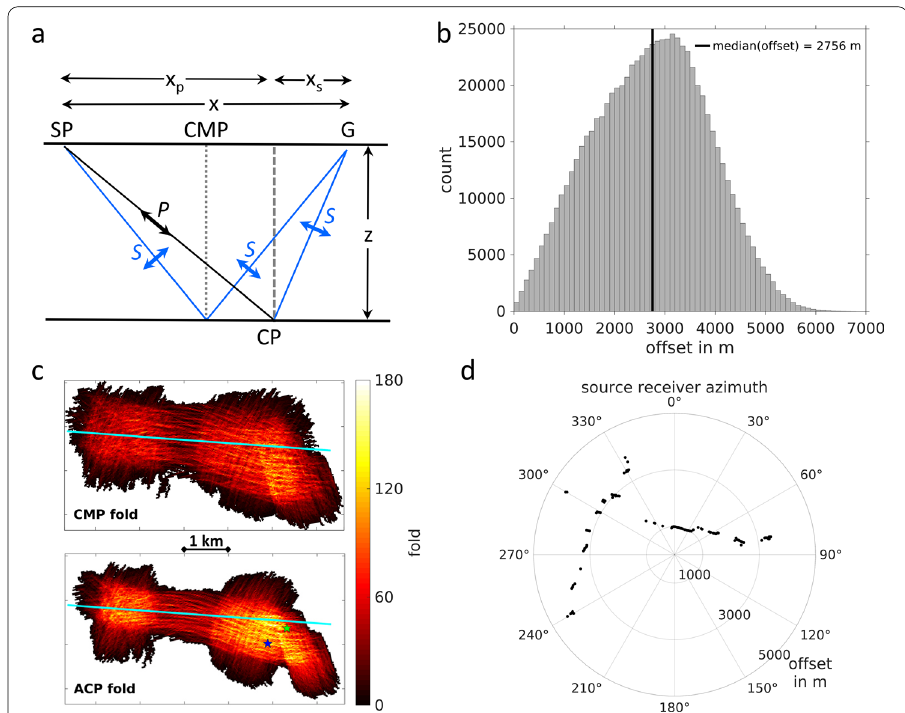
Fig. 3 Acquisition principles and parameters. a Principle of ACP-binning (modified after Behle & Dohr 1985). If a downgoing P-wave from shotpoint SP is converted at a reflector, the conversion point (CP) moves towards the receiver (G), compared to a reflection point of the same wavetype (CMP). Black and blue arrows mark polarizations, i.e., particle motions, x is the offset between SP and G, x p and x s are the distances from SP to CP and from CP to G, respectively. b Distribution of absolute offset of our 3D3C dataset. The offset varies from 0 to 6852 m, with a median value (black line) of 2756 m. c Map of CMP and ACP fold of our 3D3C dataset. In the case of ACP-binning, the fold is higher but covers a smaller area. The cyan line marks the position of the cross section in Fig. 7. The blue star marks the position of the ACP bin shown in Fig. 3d and the green star marks the center of the supergather shown in Fig. 6. d Offset and azimuthal coverage of an example ACP bin. The azimuthal coverage is limited due to the linear receiver